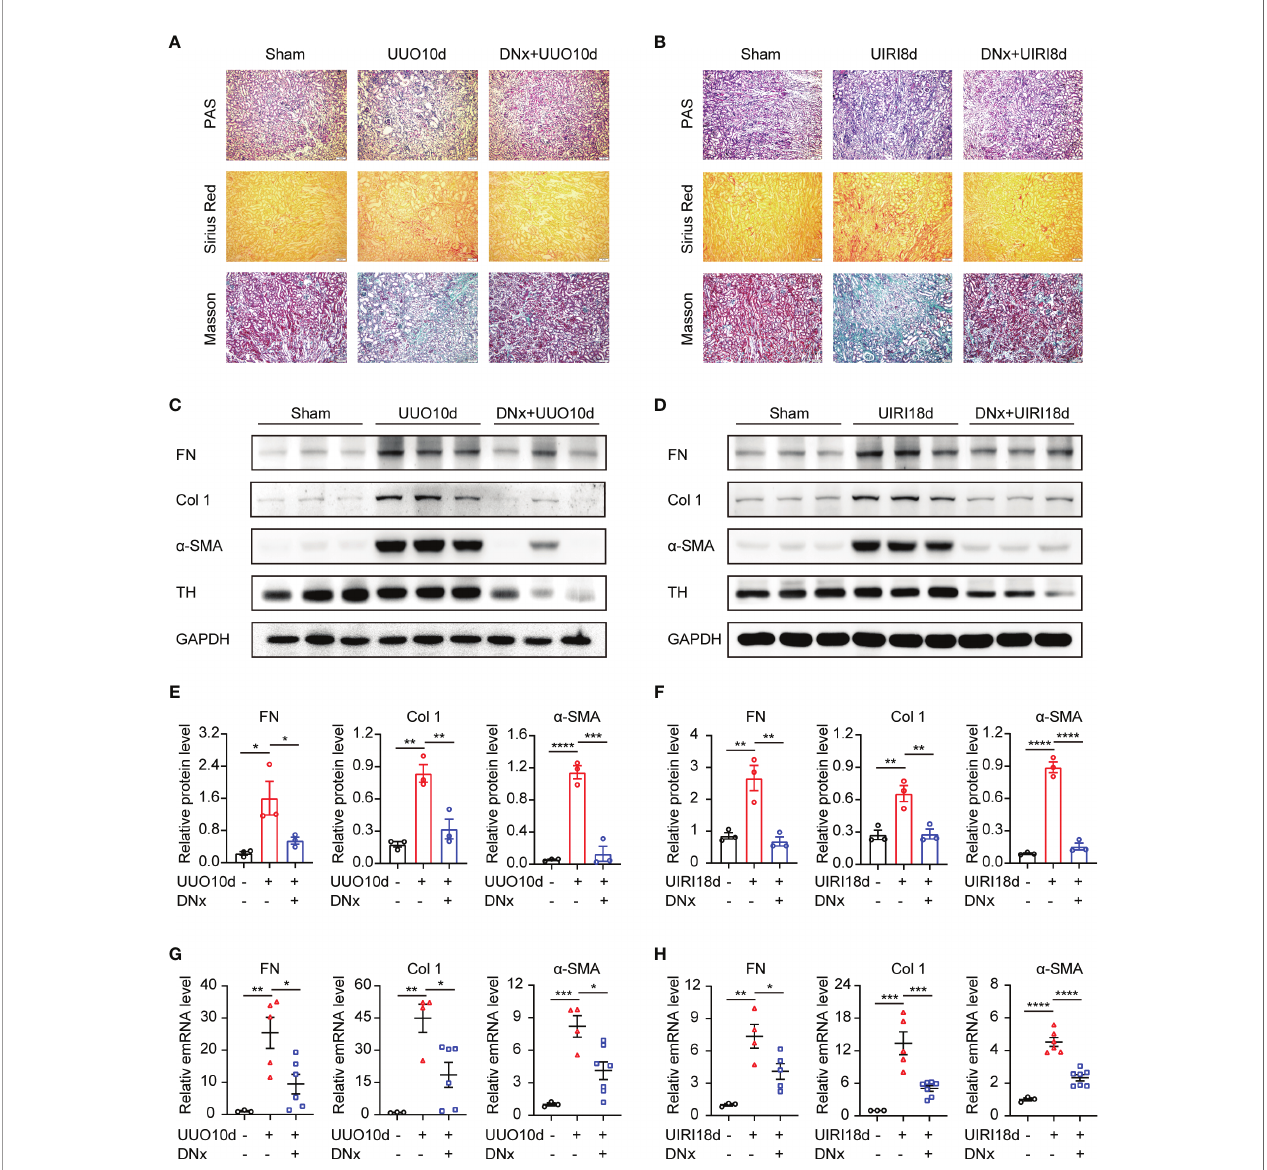
FIGURE 1 | Renal denervation inhibits the fi brotic phenotype during UUO and UIRI. C57BL/6 mice were subjected to UUO or UIRI manipulation 2 days after renal denervation (DNx) or sham operation in the left kidneys. (A, B) Representative histology of kidney sections from sham-operated, UUO/UIRI mice, and DNx+UUO/UIRI mice stained with periodic acid – Schiff, Sirius Red, and Masson ’ s trichrome stain. Scale bar, 50 m m. (C, D) Representative Western blot of fi bronectin (FN), Collagen I (Col 1), a -SMA, and Tyrosine Hydroxylase (TH) in the kidney tissue of sham-operated, UUO/UIRI mice, and DNx+UUO/UIRI mice with densitometry analysis (E, F) . (G, H) Representative mRNA expressions of FN, Col 1, and a -SMA in the kidney tissue of sham-operated, UUO/UIRI mice, and DNx+UUO/UIRI mice using qRT- PCR analysis. n=3 – 7 in each group. *P < 0.05, **P < 0.01, ***P < 0.001, ****P < 0.0001. Bars represented means ±